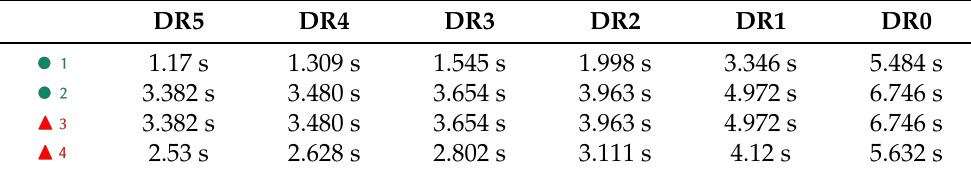
Table 8. Total time spent by the node in a communication phase for the various situations.